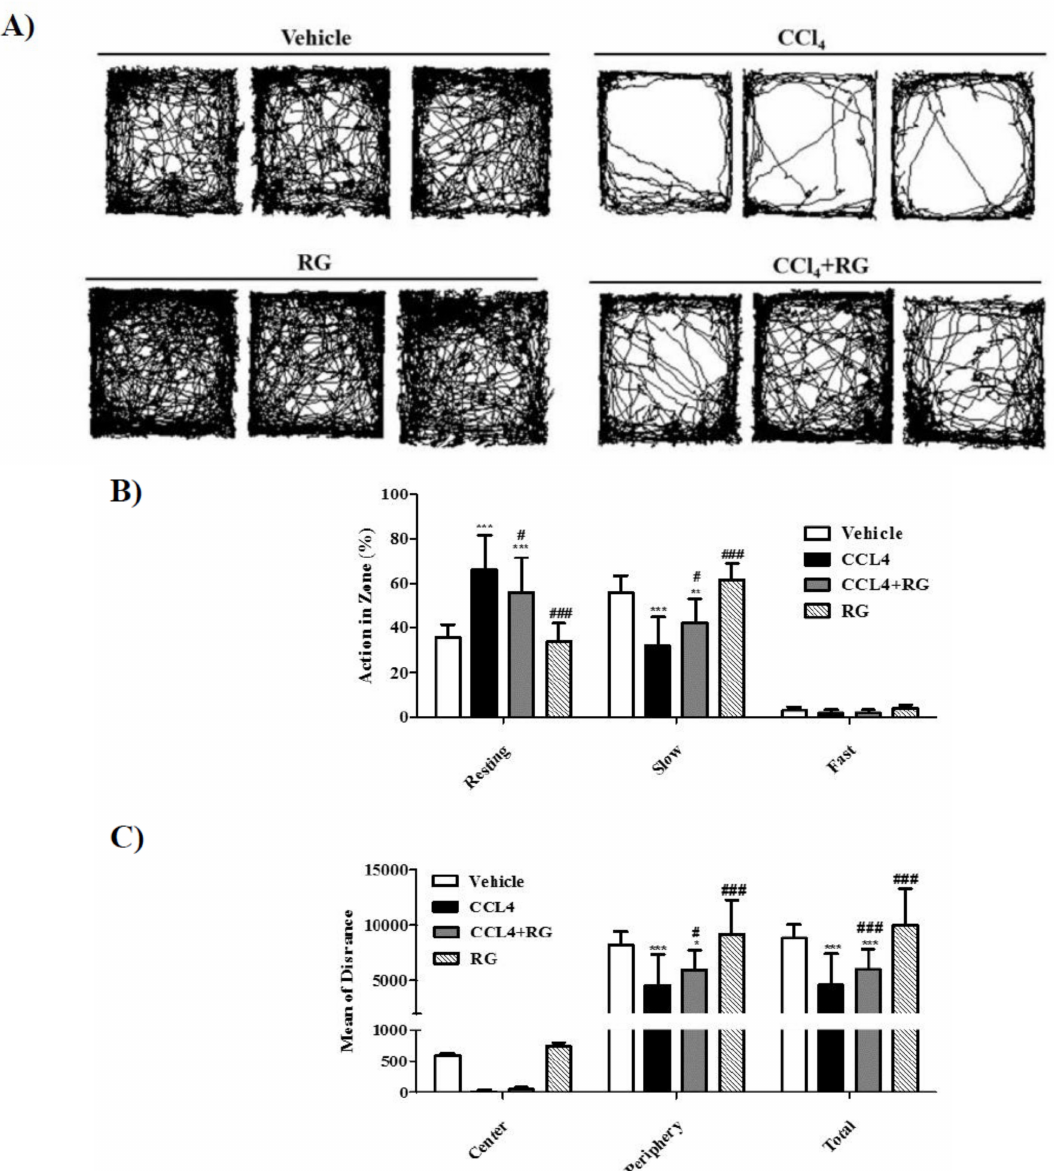
Figure 3. RG ameliorates neurobehavioral changes in CCl 4 -induced hepatic damage model. Neurobehavioral changes observed in the open field tests (OFTs) in CCl4-induced hepatic damage model. ( A ) Representative traces of mouse movement in the experimental field. ( B ) % action categories (resting, slow, and fast) in both center and periphery zones by mice. ( C ) Distance travelled in both center and periphery zones by mice. Data were analyzed for statistical significance using ANOVA with Tukey’s test for ad hoc multiple comparison implemented in GraphPad Prism. Data were presented as mean ± SD for three independent experiments. * p < 0.05, ** p < 0.01, *** p < 0.001 when compared with vehicle group; # p < 0.05, ## p < 0.01, ### p < 0.001 when compared with group CCl 4